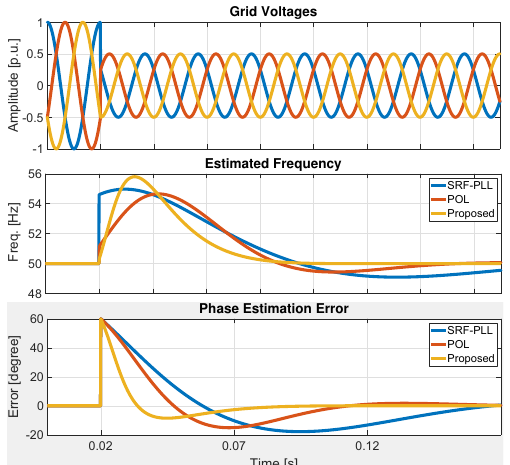
Figure 5. Comparative numerical simulation results for Test-III: Simultaneous − 0.5 p.u.amplitude and 60 ◦ phase